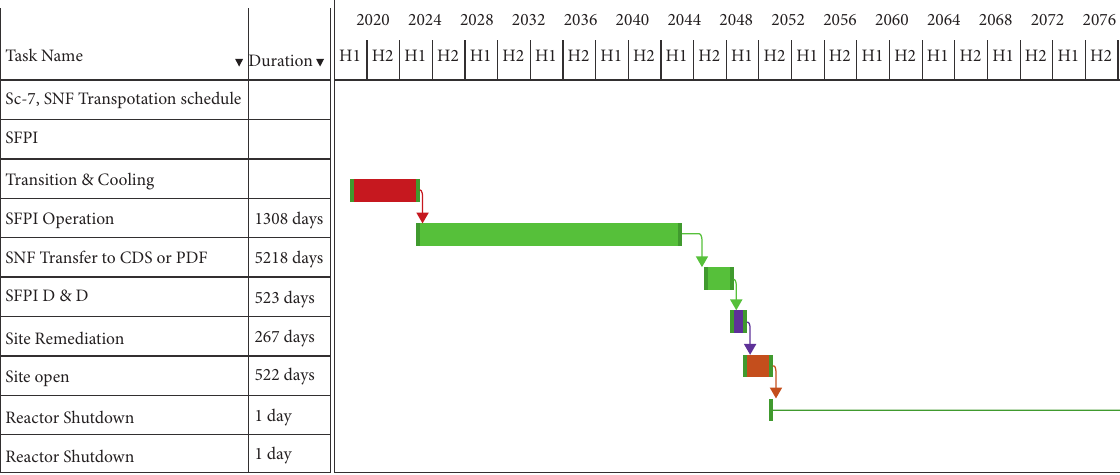
Figure 17: Sc-7 SNF transportation schedule to storage facilities.